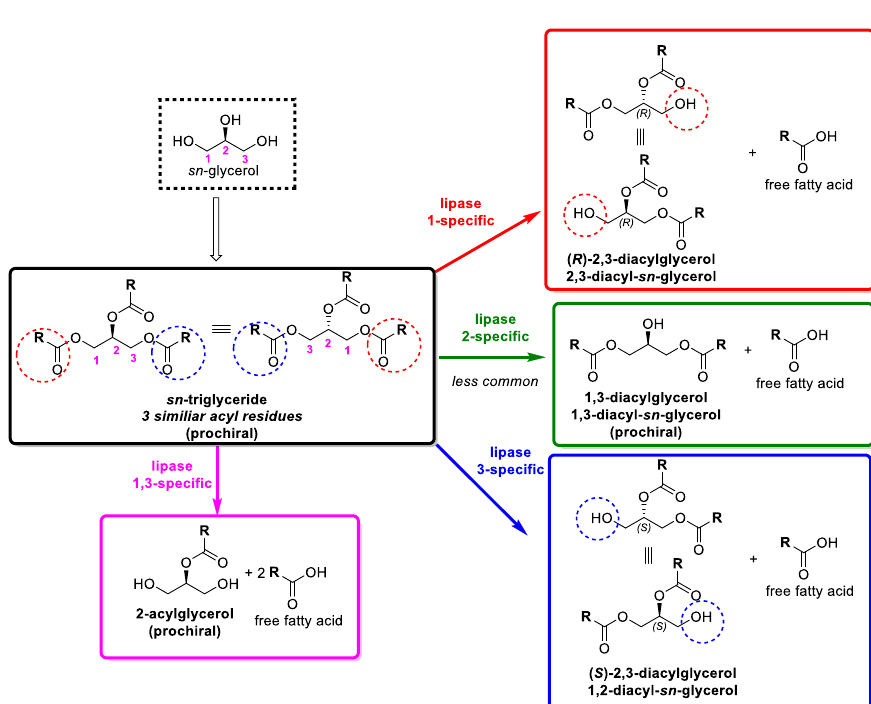
Figure 8. Diversity of reaction products in the first step of a lipase-catalyzed hydrolysis of a triglyceride possessing three identical acyl groups.